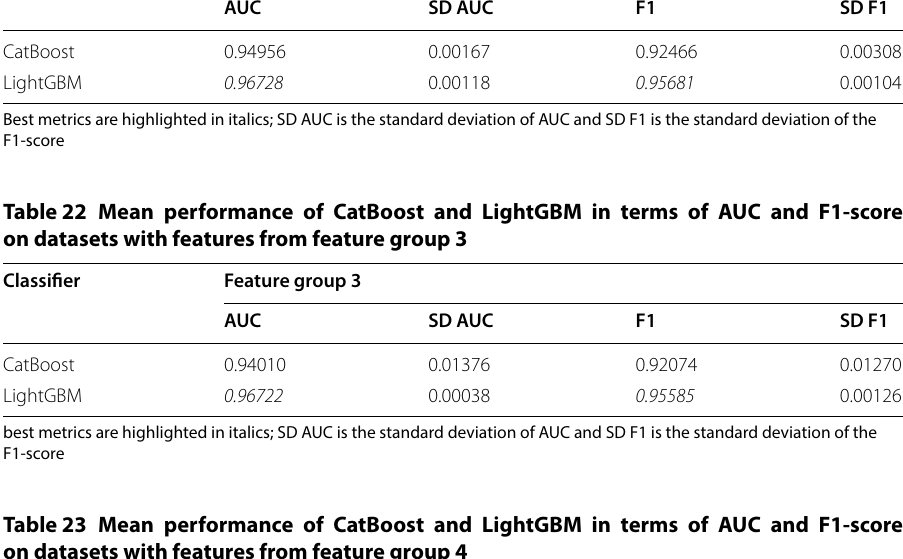
Best metrics are highlighted in italics; SD AUC is the standard deviation of AUC and SD F1 is the standard deviation of the F1-score Table 21 Mean performance of CatBoost and LightGBM in terms of AUC and F1-score on datasets with features from feature group 2